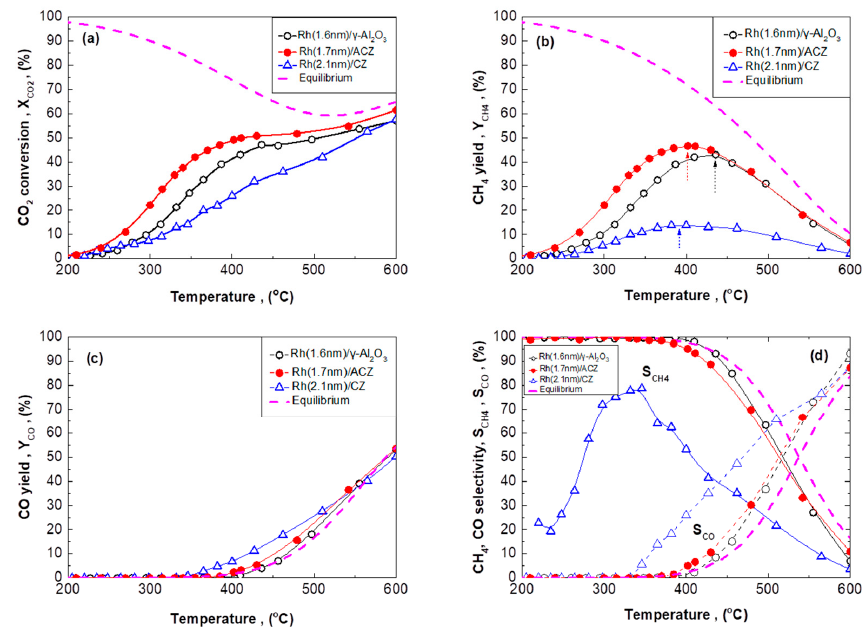
Figure 2. Conversion of CO 2 ( a ), methane yield ( b ), CO yield ( c ), and selectivities toward CH 4 and CO ( d ) as a function of temperature over the Rh(1.6 nm) / γ -Al 2 O 3 , Rh(1.7 nm) / ACZ, and Rh(2.1 nm) / CZ catalysts obtained under integral reaction conditions. Experimental conditions: feed composition of 5% CO 2 / 20% H 2 / 75% Ar at 1 bar; mass of catalyst m ca t = 50 mg; fixed mean contact time of CO 2 at τ (CO 2 )~1.3 s (see text for discussion), corresponding to wGHSV values of 93,600, 72,000, and 56,400 N mL/g ∙ h for the Rh(1.6 nm)/ γ -Al 2 O 3 , Rh(1.7 nm)/ACZ, and Rh(2.1 nm)/CZ catalysts, respectively.